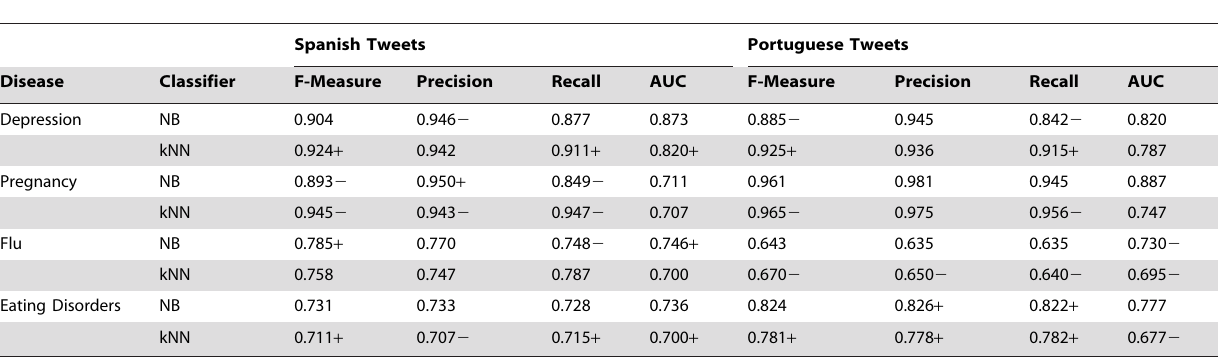
Table 10. Classification results obtained on subsets generated using